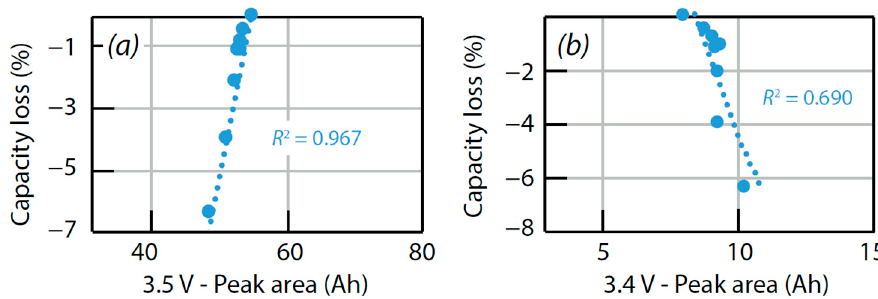
Figure 6. Capacity loss (%) as a function of peak area (3.5 V) (Ah) for cell (23 ◦ , SOC 30, 1C/1D) (( a ) is for